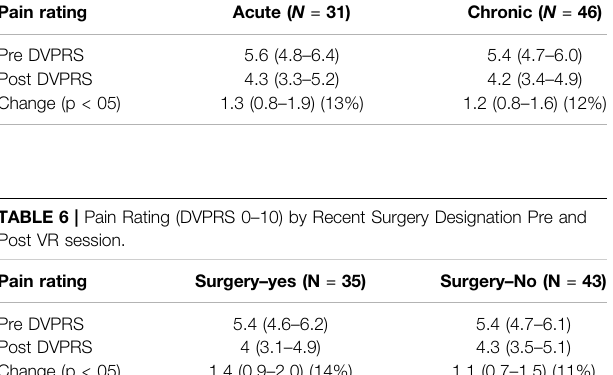
TABLE 5 | Pain Rating (DVPRS Scale 0 – 10) by Acute vs. Chronic Pain Designation. Pain rating